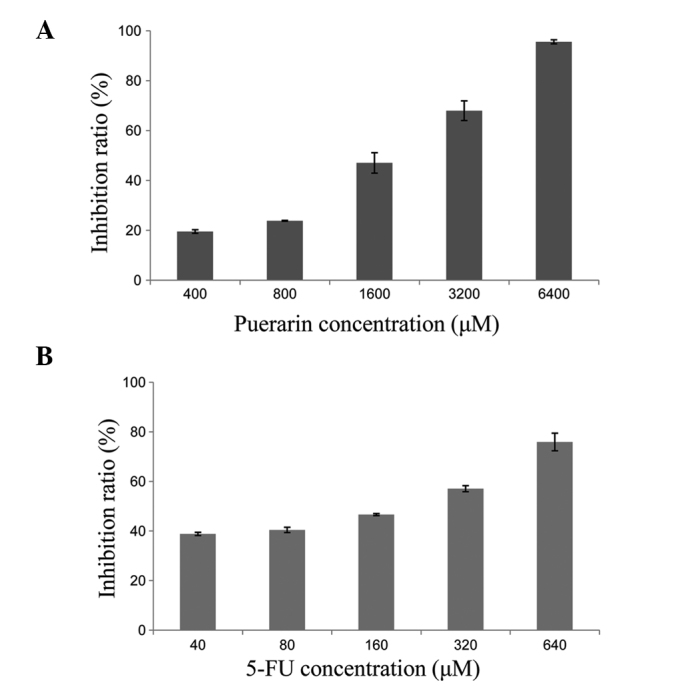
Effect of puerarin or 5-FU alone on SMMC7721 cell proliferation. (A) The proliferation of SMMC7721 cells was inhibited by puerarin in a dose-dependent manner (P<0.01). (B) Similar results were obtained for 5-FU (P<0.01). 5-FU, 5-fluorouracil.